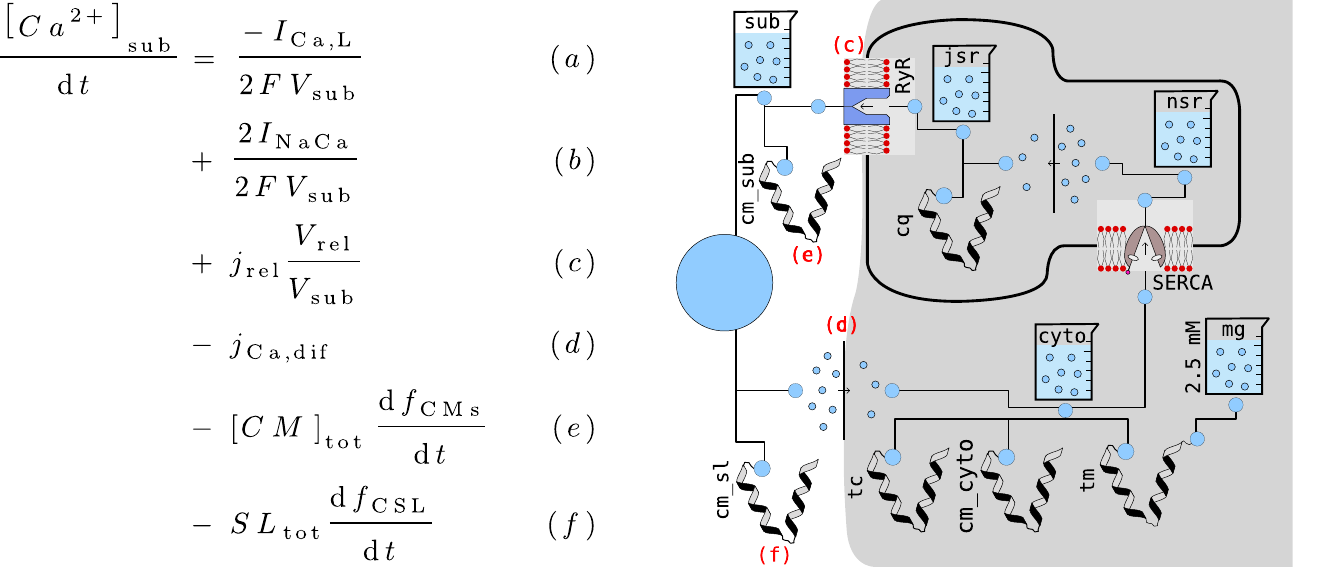
Fig 3. [ Ca 2+ ] handling in the Inada model. Left: One of the 15 differential equations that govern the intracellular calcium concentrations as presented in the original article. This single equation mixes the following six physiological effects: the transport of calcium cations through the L-type calcium channels (a) and the sodium- calcium exchanger (b), the release of calcium from the JSR into the subspace via ryanodine receptors (c), the diffusion from the subspace into the cytosol (d), and the calcium buffer calmodulin in the subspace (e) and in the sarcolemma (f). Right: Graphical representation of the [ Ca 2+ ] handling in InaMo version 1.4.1. Each component represents a single physiological effect or quantity with intuitive icons for concentrations (beaker), calcium buffers (stylized protein), diffusion reactions (arrow from high to low concentration of circles), the ryanodine receptor (pore in lipid bilayer), and the SERCA pump (scissor-like structure in lipid bilayer). Effects (c)–(f) of the left-hand side equation are represented by the four components connected to the beaker on the upper left (marked in red), while effects (a) and (b) are handled by the external ion channel components when they are connected to the large calcium connector (blue circle) on the center left. These external connections can be seen in Fig 6 (left).